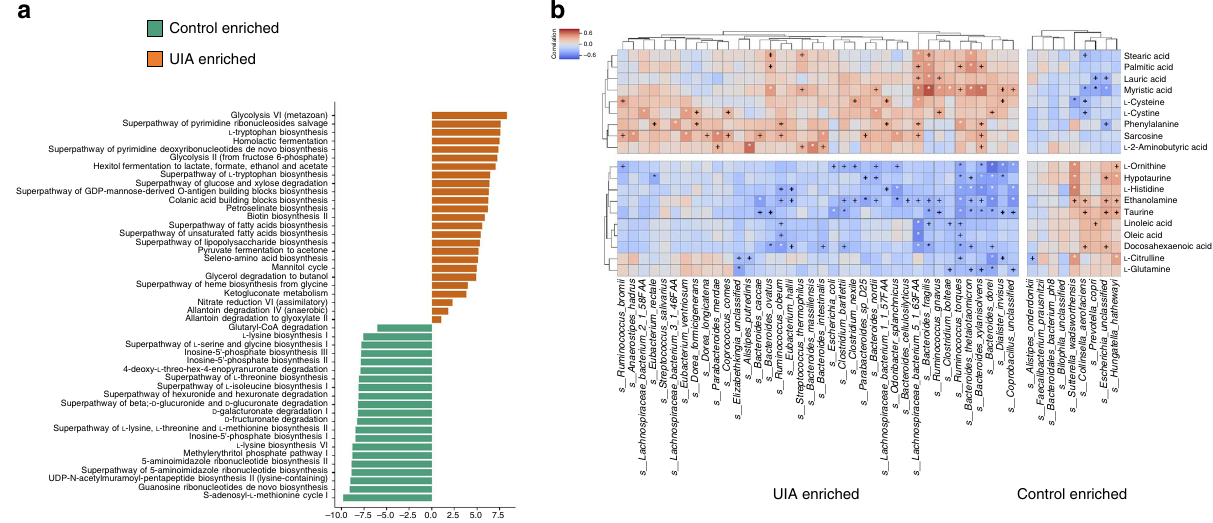
Fig. 4 Functional characterization of the UIA microbiome. a Pathways with biologically signi fi cant differential abundance between UIA patients and controls ( n = 100). Turquoise and orange, control- and UIA-enriched pathways. b Heat maps of Spearman ’ s rank correlation coef fi cients between 19 altered amino acids and fatty acids and 47 UIA-associated gut microbial species. + P < 0.05, * P < 0.01. Pairs with low correlations (| r | < 0.4) are not shown ( n = 30). Source data are provided as a Source Data fi